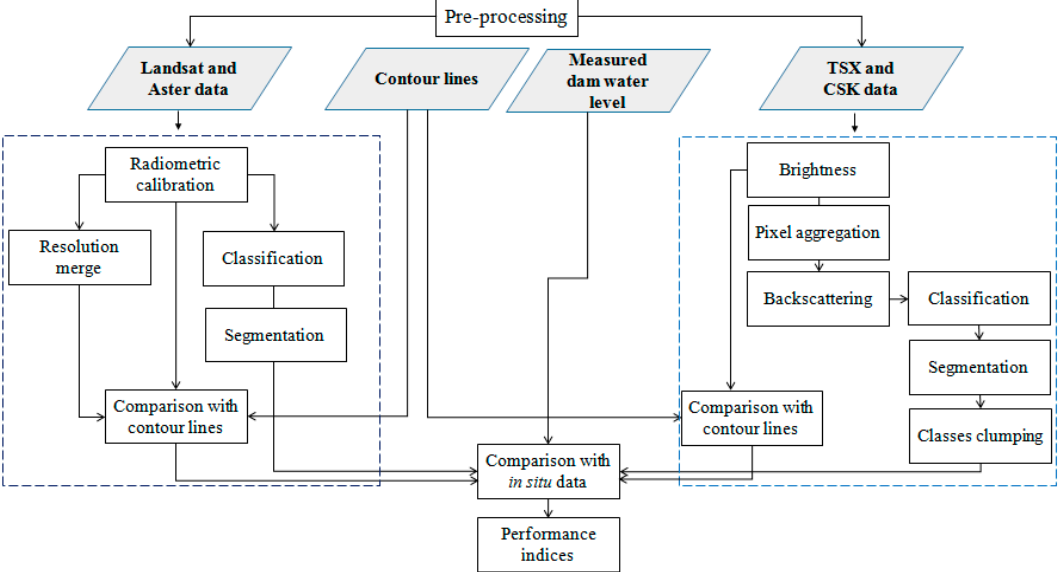
Figure 1. Flow diagram of optical and SAR imagery processing.